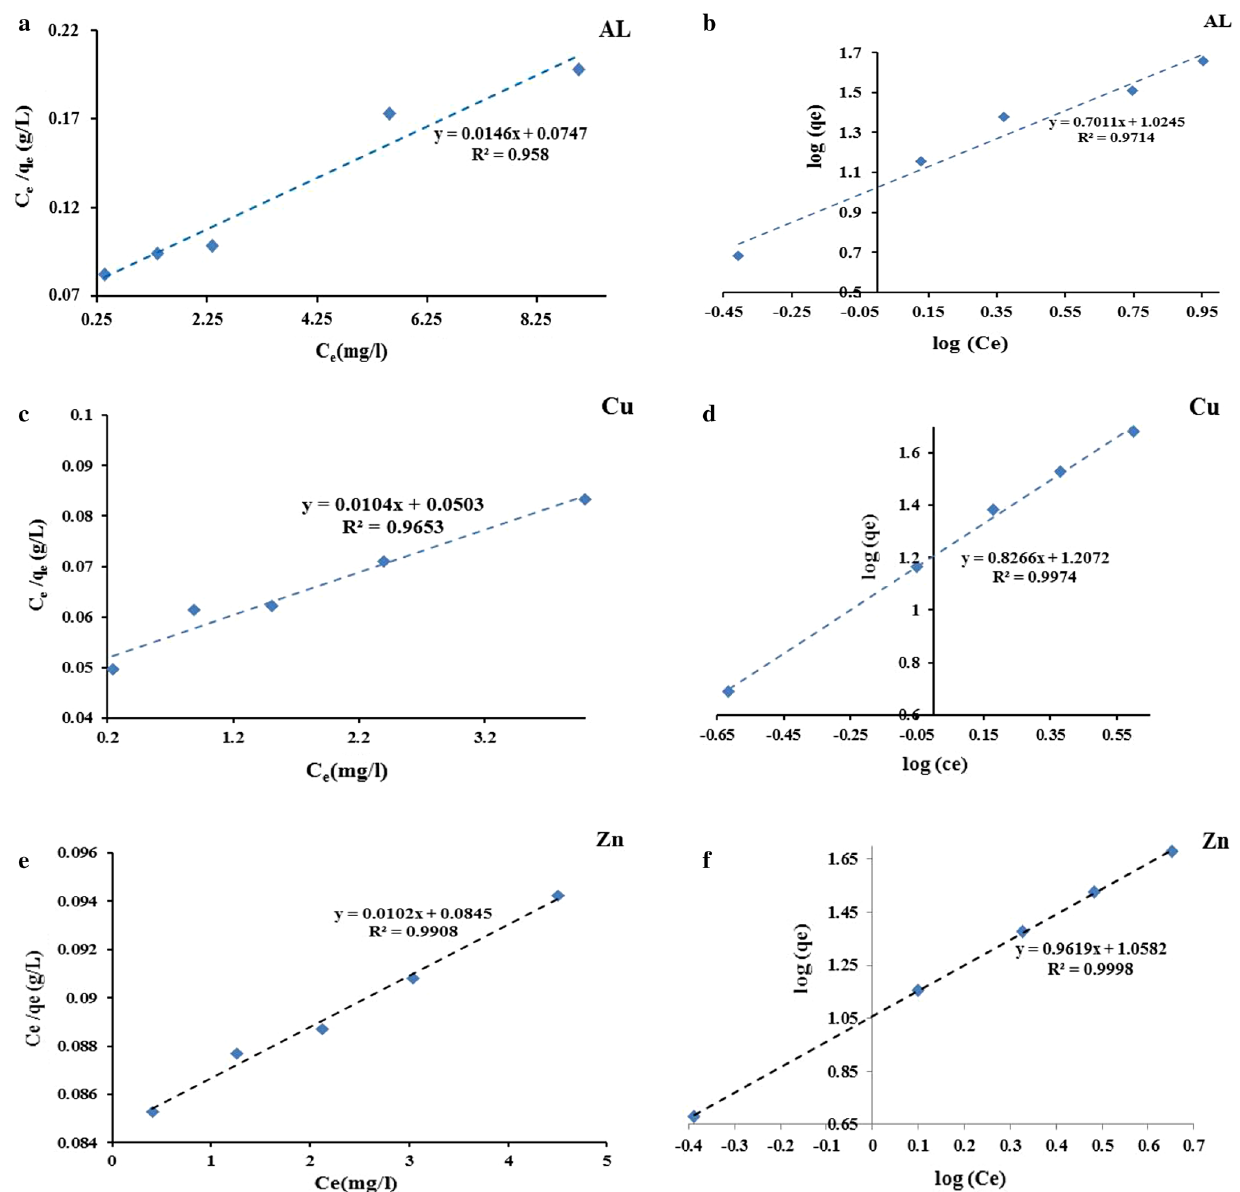
Fig. 11 a Langmuir isotherm for the adsorption of Al(III) by MZNCs; b Freundlich isotherm for the adsorption of Al(III) by MZNCs; c Langmuir isotherm for the adsorption of Cu(II) by MZNCs; d Freundlich isotherm for the adsorption of Cu(II) by high concentrations (0.5–3 g/l) of Cu(II) and Zn(II) within Al(III), Cu(II) and Zn(II) with 0.958, 0.9653 and 0.9908 correlation coefficient ( R 2 ) for Al(III), Cu(II) and Zn(II), respectively. But Freundlich isotherm fits the experimental